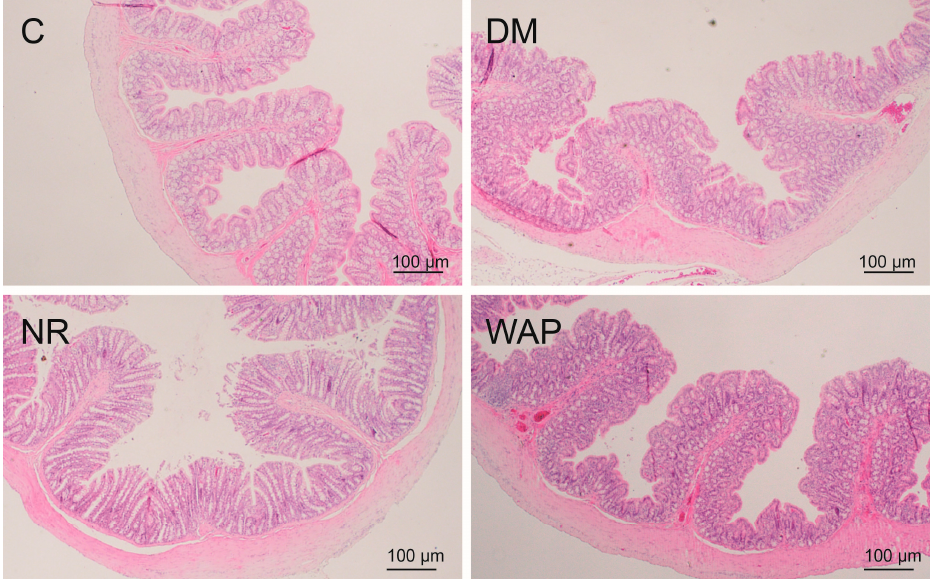
Figure 3. Colon structure (magnification, 40×) of the control group (C), antibiotic-associated diarrhea group (DM), natural recovery group (NR), and Astragalus polysaccharide group (WAP).